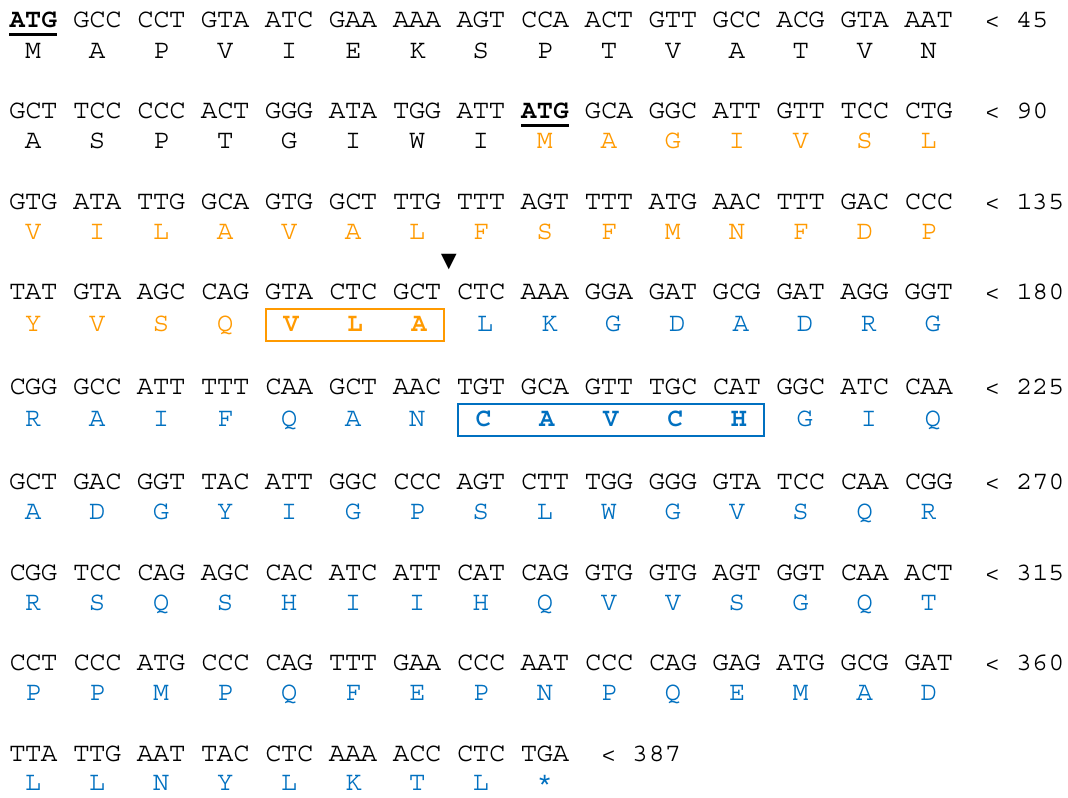
Figure 1. Cyt c M protein and gene sequences from Synechocystis sp. PCC 6803. The two potential translation initiation sites are underlined. The black triangle separates the hydrophobic region (orange) from the hydrophilic one (blue) and marks the point at which the signal peptide was presumed to finish, i.e., right after the VLA motif (boxed). The characteristic CXXCH heme binding motif (boxed) can also be observed.